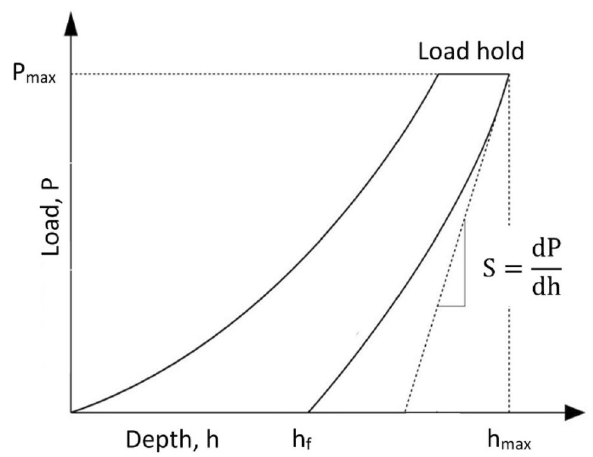
Fig. 4 Indentation load–depth